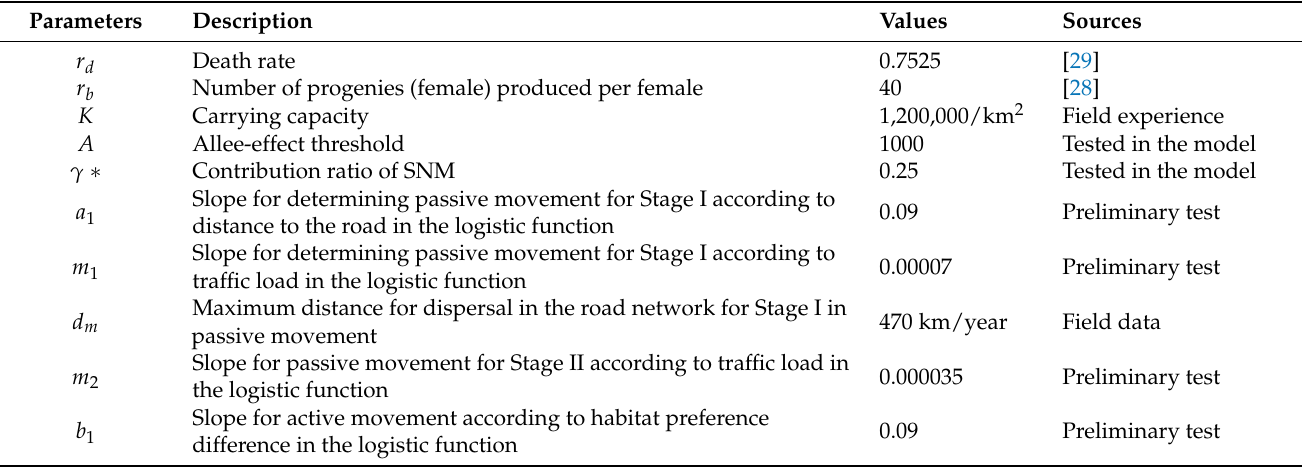
Table 1. Parameters and variables used for LSM and SNM (* Used for SNM, otherwise for